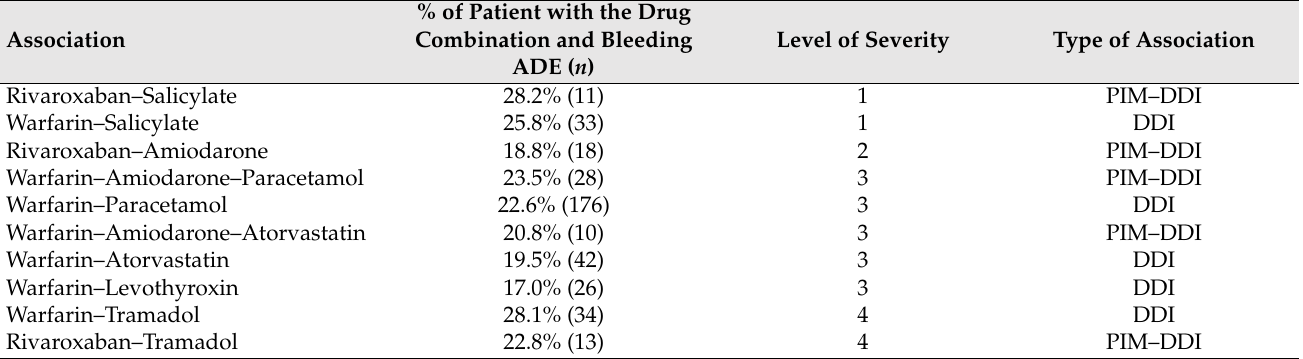
Table 4. Top 10 drugs involved in DDI or in PIM–DDI. The percentage are calculated as the ratio of the number patients with the drug combination and a bleeding ADE and the total number of patients with the drug combination.